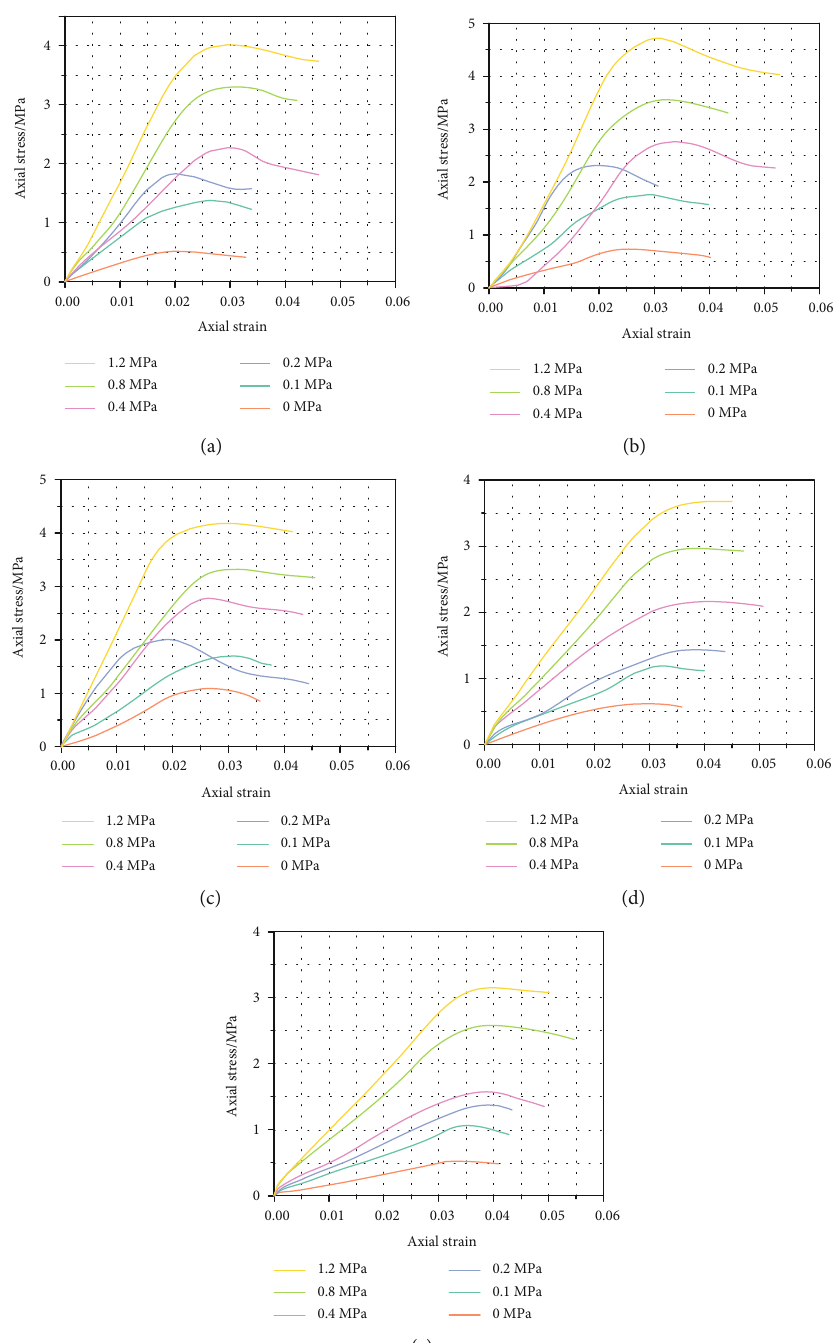
Figure 3: Relationship between axial stress-strain curve and con fi ning pressure under di ff erent moisture content conditions. (a) Moisture content 4%. (b) Moisture content 6%. (c) Moisture content 8%. (d) Moisture content 10%. (e) Moisture content